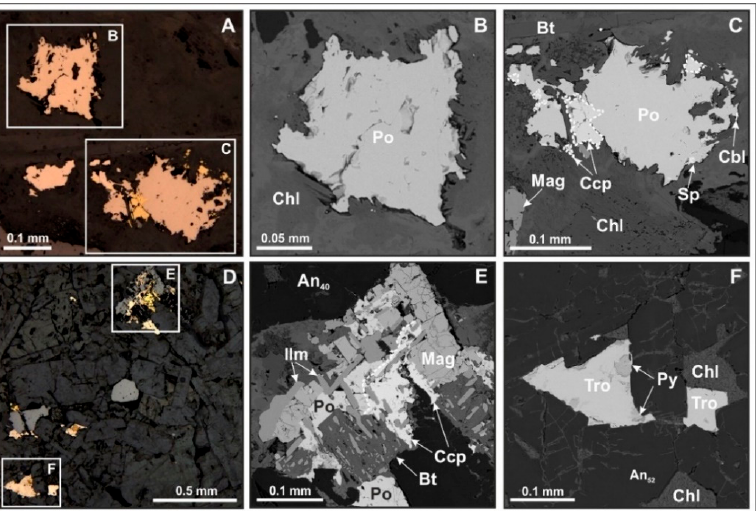
Figure 8. Pyrrhotite (Fe 1-x S) and troilite (FeS) from the Kochumdek gabbro. ( A , B ) Individual pyrrhotite grains. ( C ) Aggregate of chalcopyrite and pyrrhotite with small cobaltite and sphalerite inclusions. (D, E ) Typical intergrown of accessory phases (Ti-bearing magnetite and ilmenite) with pyrrhotite and chalcopyrite. (D, F ) Small troilite grain with pyrite inclusion. ( A , D ) = optical images in polarized reflected light; ( B , C , E , F ) = backscattered electron images (BSE). Samples: ( A–C ) = PK-7-1, ( D–F ) = PK-4-8. An = anorthite, Bt = biotite, Cbl = cobaltite, Ccp = chalcopyrite, Chl = chlorite, Ilm = ilmenite, Mag = magnetite, Py = pyrite, Po = pyrrhotite, Sp = sphalerite, Tro = troilite.